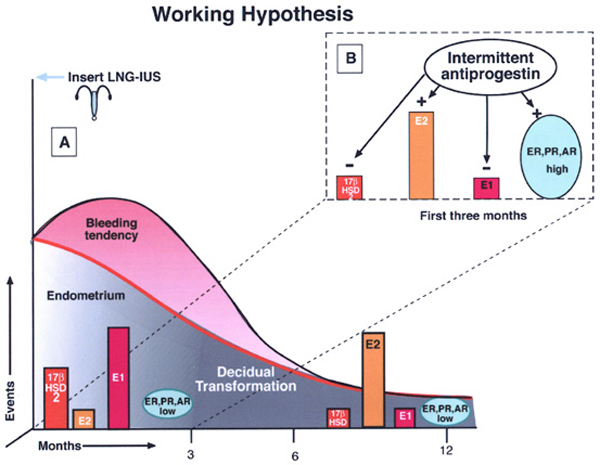
Endometrial changes after insertion of an LNG-IUS; the effects of intermittent antiprogestin therapy on bleeding. A working hypothesis. A Insertion of an LNG-IUS induces a process of decidualisation (grey colour) in the endometrium. During the first 3 months bleeding is high then slowly improves. During this time, 17βHSD-2 is elevated and therefore estrone, E1 (a less potent estrogen) is high and estradiol, E2 (the more potent estrogen) is low; steroid receptors are suppressed. After 6 months, when decidualisation is extensive, bleeding is reduced, 17βHSD-2 is low, E2 is high and E1 is low. Steroid receptors remain low, (though ERβ is likely to be present in the vascular endothelium). This balance of steroids at 6 months is associated with reduced bleeding. B. Intermittent antiprogestin treatment during the first 3 months will suppress 17βHSD-2 and thereby lower E1, elevate the more potent E2and elevate steroid receptors. This balance of steroids is similar to the balance at 6 months, but would allow E2 to interact with higher levels of receptors in all cell types and should suppress BTB. In addition, the spiral arteries would be strongly inhibited by antiprogestins, which should also suppress BTB. This periodic "putting on the brakes" on bleeding may help women through the most difficult period of adjustment to an LNG-IUS, after which antiprogestin treatment could be stopped.